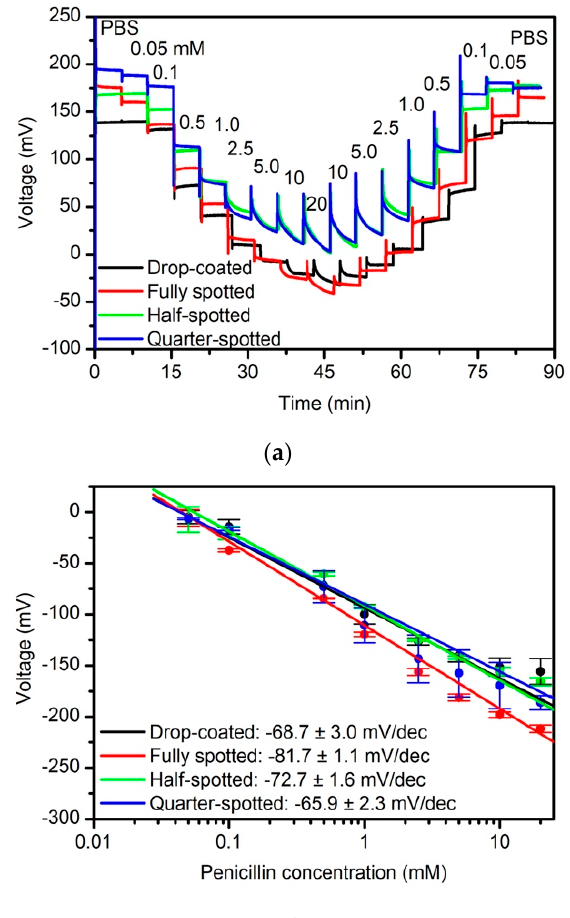
Figure 3. ( a ) ConCap measurements of different prepared EIS biosensors modified with the enzyme penicillinase (drop-coating: black curve, fully spotted: red curve, half-spotted: green curve and quarter-spotted: blue curve) measured in PBS, pH 8, with different penicillin concentrations from 0.05 mM to 20 mM; ( b ) corresponding calibration curves evaluated from ConCap response in the linear concentration range; PBS: polymix multi-component buffer solution; number of investigated sensors for each type N = 3.